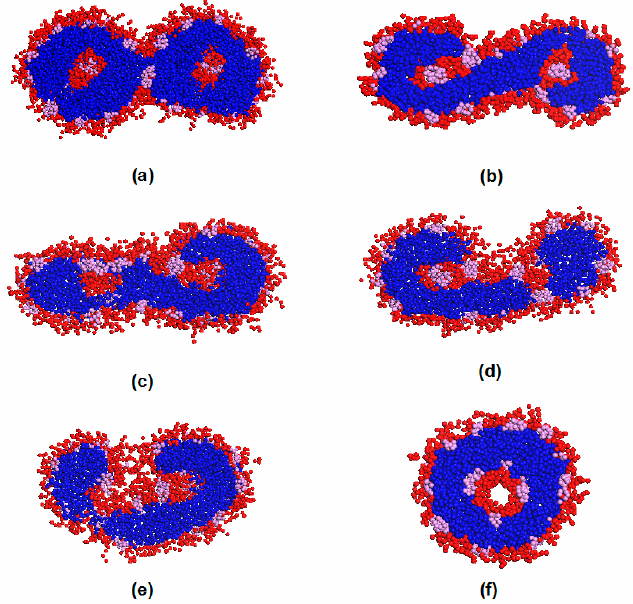
Figure 7. Morphology transition during the combination of two vesicles with a core over the periods of 4.24 × 10 5 DPD steps to 5.0 × 10 5 DPD steps: ( a ) at 424,000 DPD steps; ( b ) at 430,000 DPD steps; ( c ) at 450,000 DPD steps; ( d ) at 470,000 DPD steps; ( e ) at 485,000 DPD steps; and ( f ) at 500,000 DPD steps. The blue, red, and pink colors represent E, O, and F, respectively, while solvent molecules are omitted for clarity.